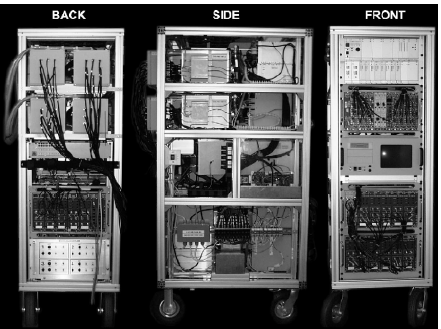
Figure 10. Photo of the 32-channel TD-NIRS system, “MOSTIR”, developed by a group in the UK [49]. Reproduced from Reference [49].